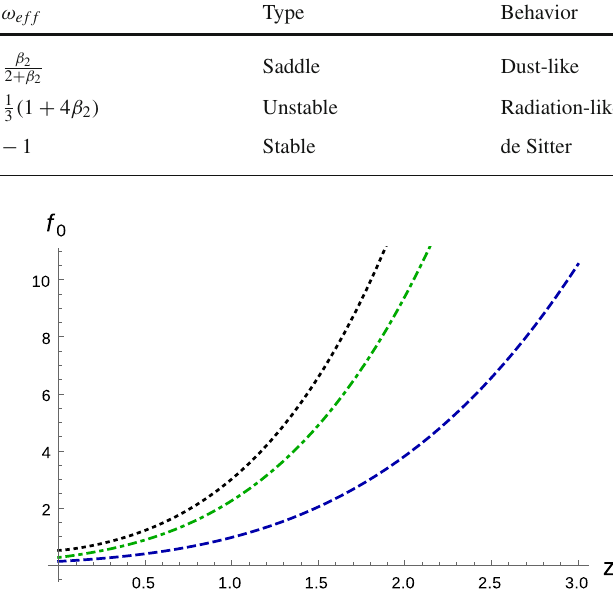
Fig. 3 The evolution of the non-conservation of the energy– momentum tensor f 0 as a function of the redshift z for three different values for the constant η = − 0 . 02 (dot-dashed), η = 0 (dashed) and η = 0 . 1 (dotted). We use the best fit values for the model parameters presented in Table 2 For redshifts greater than z > 0 . 2 the non-conservation